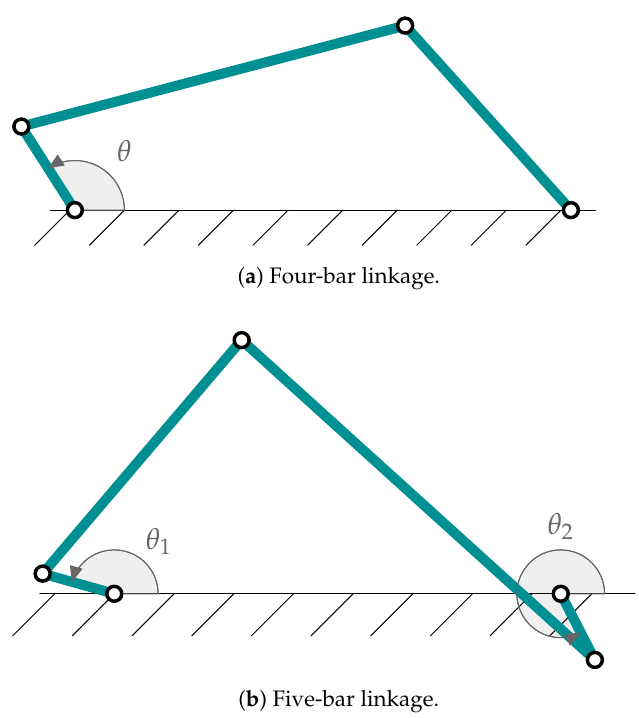
Figure 1. Mechanisms employed in this work. Table 1. Properties of the four-bar linkage.